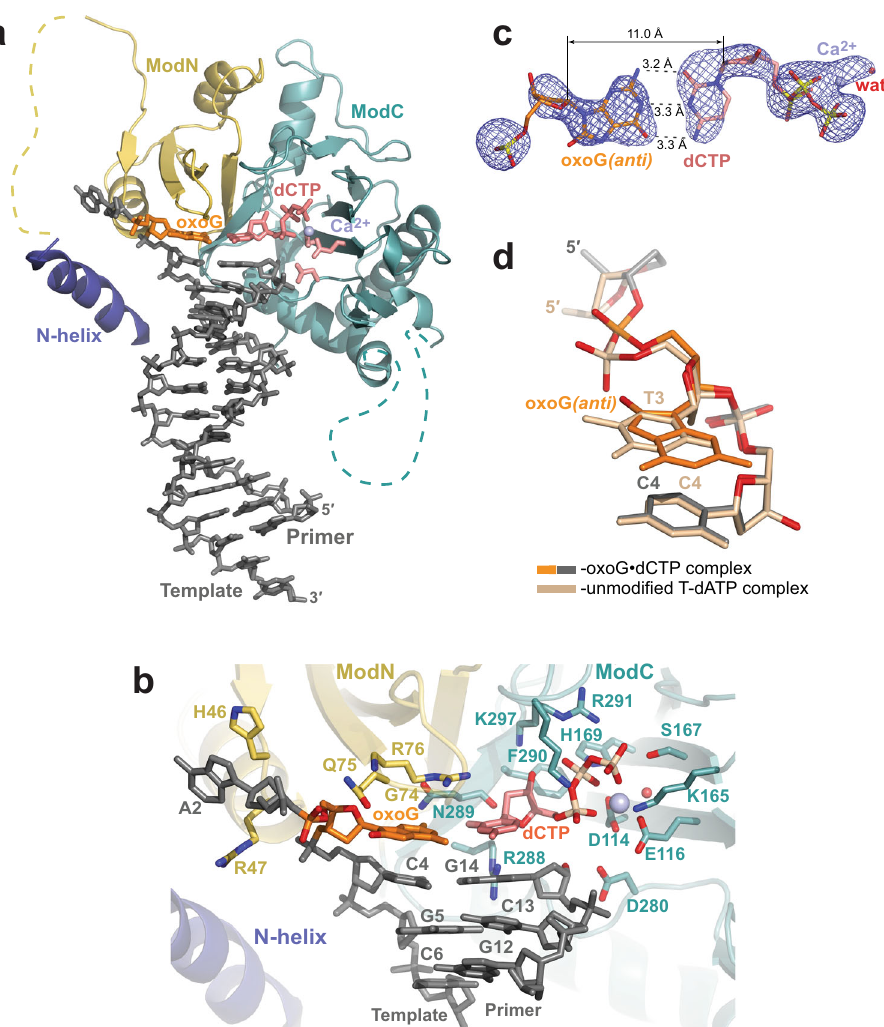
Fig. 1 Structure of human PrimPol inserting correct dCTP opposite the oxoG template base. a The overall structure of the ternary PrimPol oxoG • dCTP complex (molecule A complex in the asymmetric unit (AU) with the ordered N-helix). The N-helix and modules ModN and ModC are shown in cartoon representation in dark blue, yellow, and cyan, respectively. The DNA is shown as gray sticks, and the Ca 2 + ion ( ‘ metal B ’ ) is shown as a light blue sphere. The oxoG residue (orange) is forming a nascent base pair with the incoming dCTP (red). The unstructured regions in the ModN and ModC modules are shown as dashed yellow and cyan lines, respectively. The side chains of key catalytic active-site residues Asp114, Glu116, and Asp280 are shown as red sticks. b A close-up view of the oxoG template base and the dCTP in the PrimPol active site. The key catalytic residues (Asp114, Glu116, and Asp280), the residues contacting the incoming dCTP (Lys165, Ser167, His169, Arg288, Asn289, Phe290, Arg291, and Lys297), the template oxoG base (Gly74, Gln75, and Arg76), and the rest of the template strand (Lys10, His46, and Arg47) are shown in sticks and with oxygen atoms in bright red and nitrogen atoms in blue. c A simulated annealing Fo − Fc omit map (contoured at 2.5 σ -level at 2.60 Å resolution and colored in blue) showing the clear electron density for the entire oxoG residue in the anti conformation, its partner incoming dCTP, and the Ca 2 + ion. Hydrogen bonds are indicated by black dashes. d Comparison of the phosphate backbone conformations of C2-oxoG3 (anti) -C4 (gray and orange) and unmodi fi ed C2-T3-C4 (beige) template strand segments within the PrimPol active site of their respective ternary complexes. The complexes are superimposed by ModN and ModC of PrimPol protein. The oxygen atoms of the sugar-phosphate backbone and the O8 of the oxoG residue are colored in red. The phosphate group of the oxoG3 (anti) residue is shifted by ~1.5 Å compared to the position occupied by the phosphate group of T3